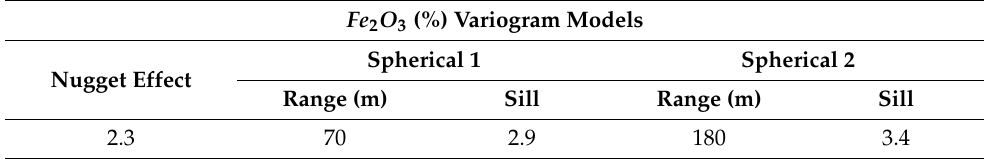
Table 2. Structures and parameters of variogram models fitted on Fe 2 O 3 (%) samples